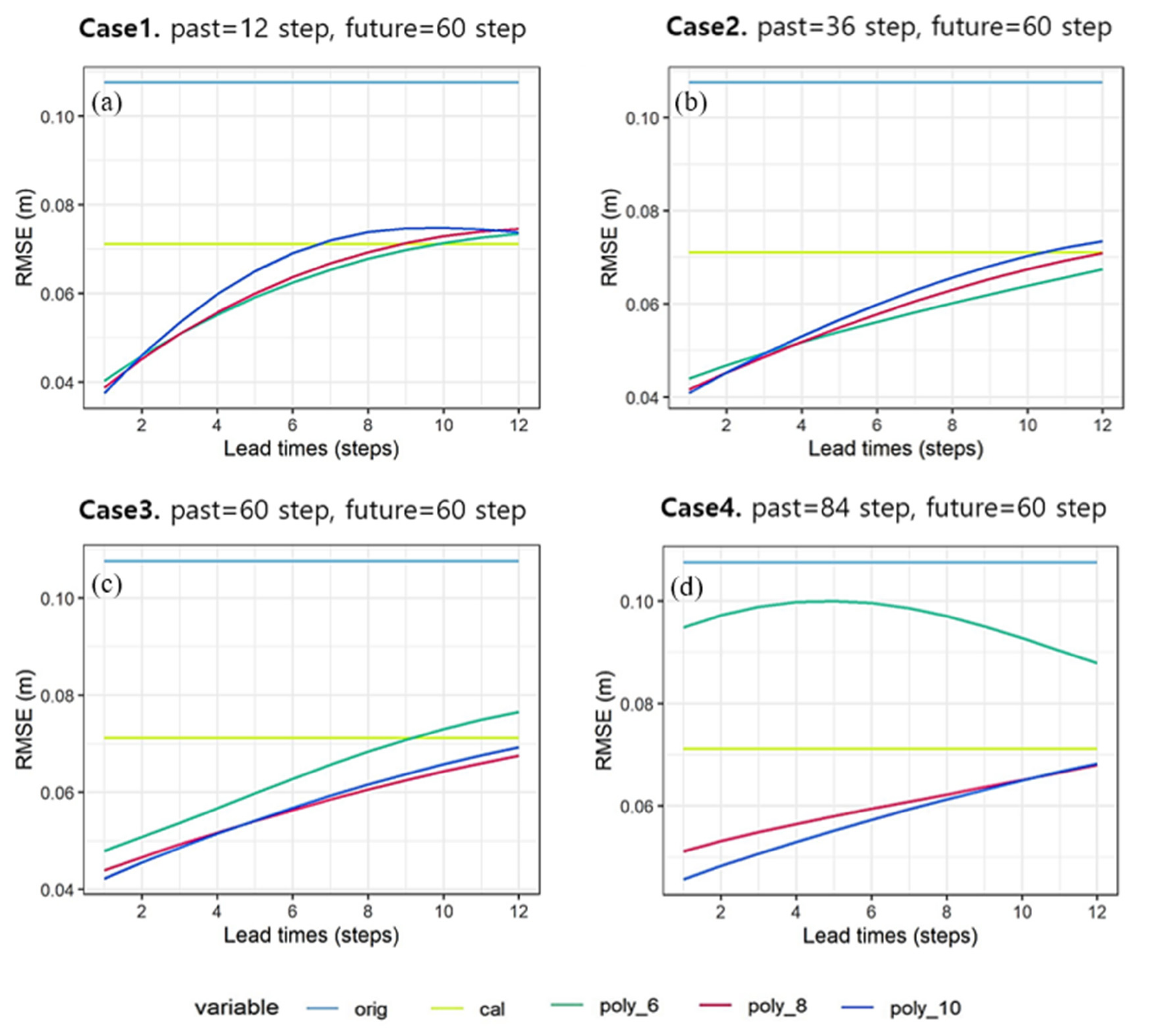
Figure 7. Tidal prediction performance is based on varying polynomial orders according to various past DA window periods: ( a ) 12 past steps, ( b ) 36 past steps, ( c ) 60 past steps, and ( d ) 84 past steps, with the same 60 future steps in all cases.